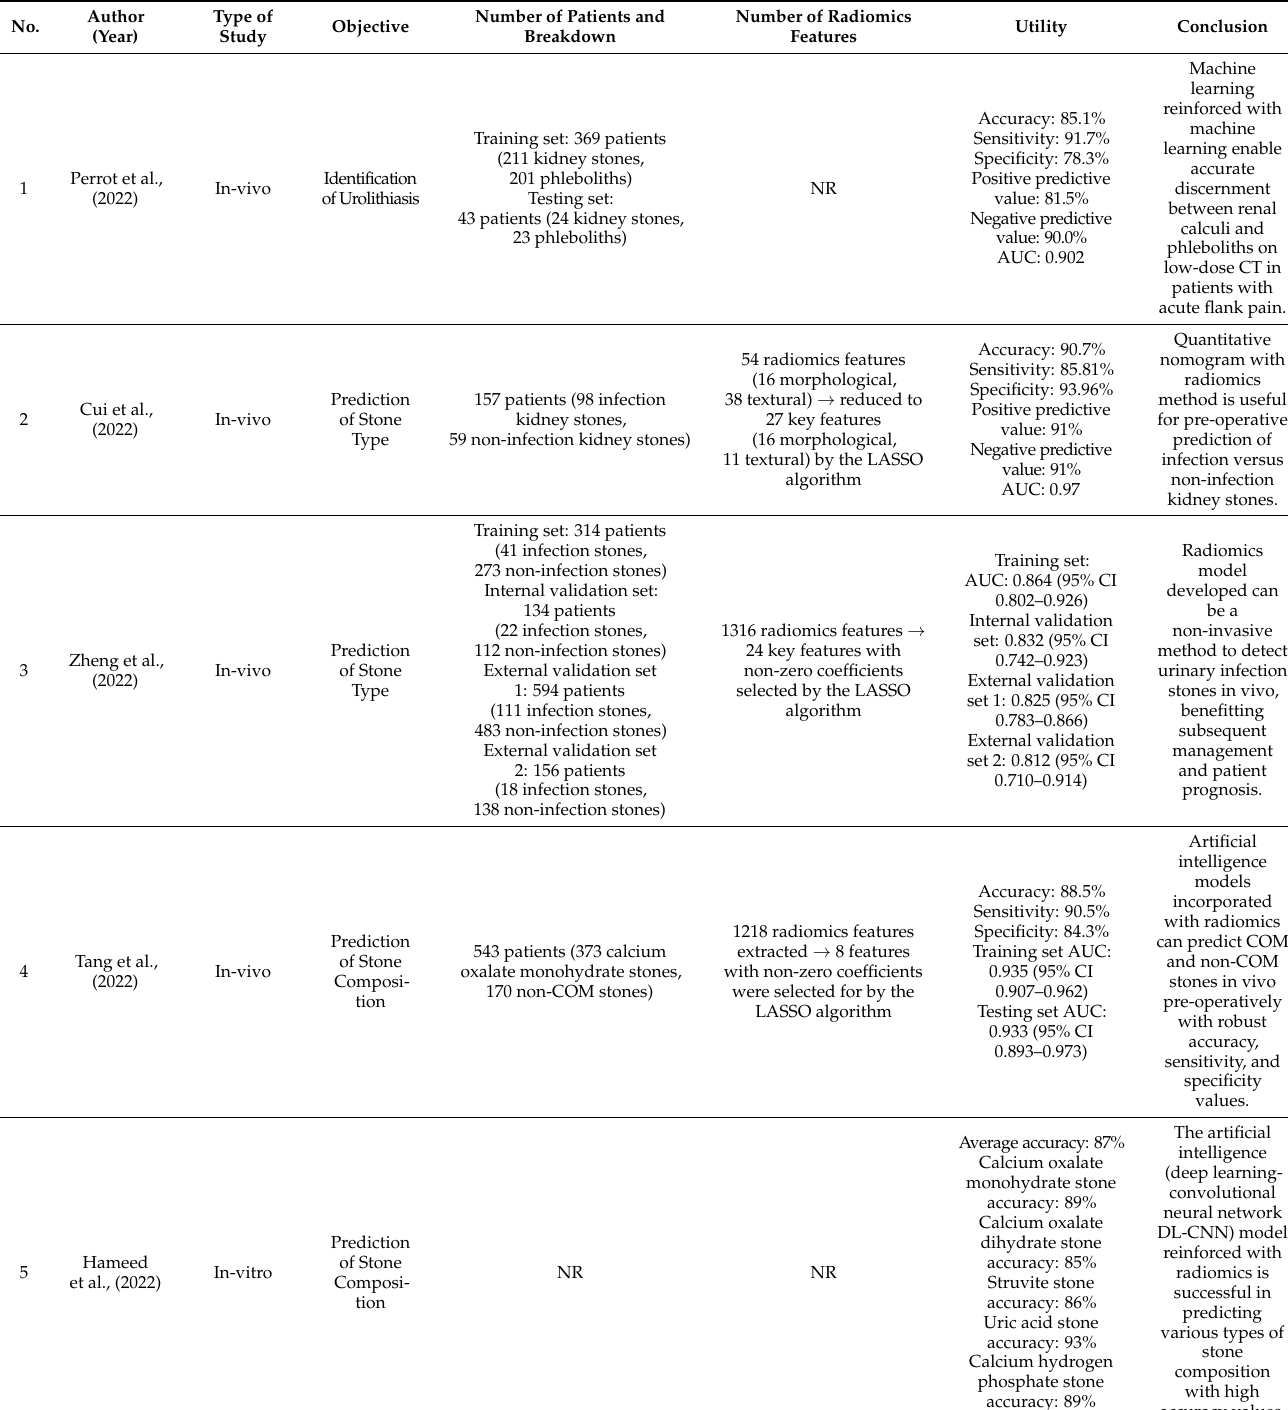
Table 1. Summary of included